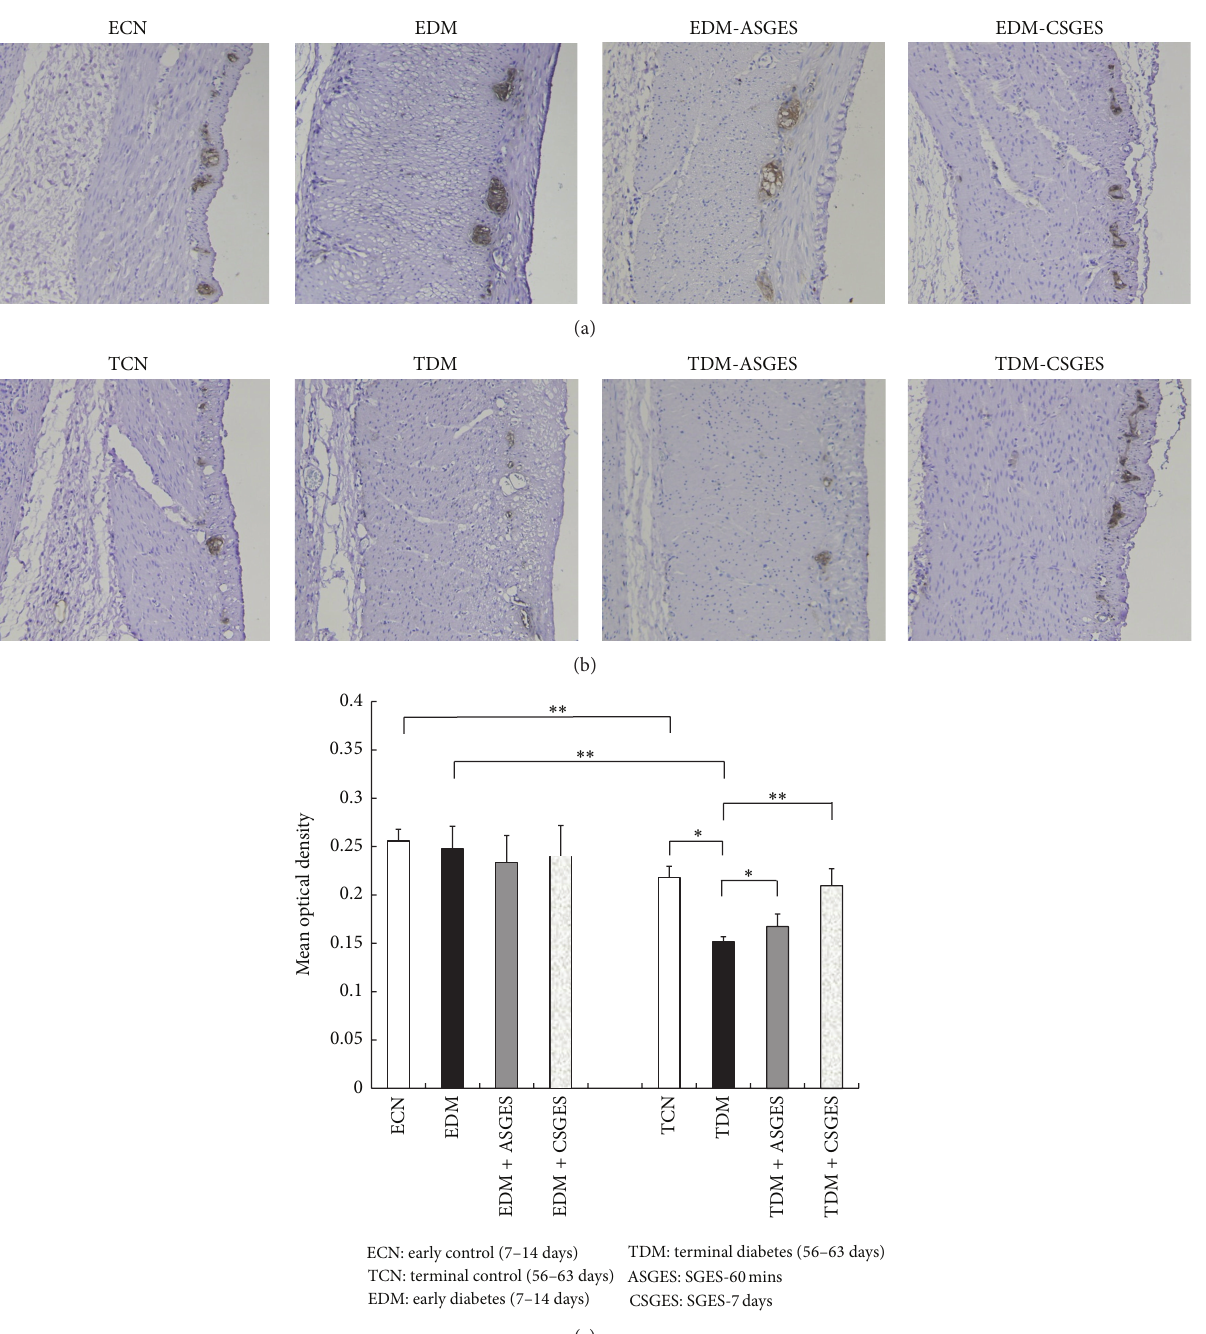
Figure 5: Immunohistochemical staining of S100B in the enteric plexus of stomach. Tissues with brown deposits were positive reaction. (a) S100B expression in ECN, EDM, EDM + ASGES, and EDM + CSGES. (b) S100B expression in TCN, TDM, TDM + ASGES, and TDM + CSGES. (c) Semiquantification of S100B-positive cells in each group. There were no significant differences between ECN and EDM. The expression of S100B in TDM and TCN groups was lower than in EDM and ECN groups, respectively. ASGES and CSGES had little effect on the expression of S100B in EDM. Comparing with TDM group, the immunopositive stain was decreased significantly in TDM group. But the immunopositive stain significantly increased after ASGES and CSGES. Data are presented as means ± SD. ∗ 𝑃 < 0.05 , ∗∗ 𝑃 < 0.01